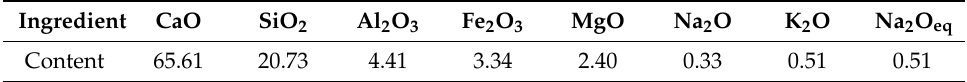
Table 3. Experimental methods and properties of concrete with and without